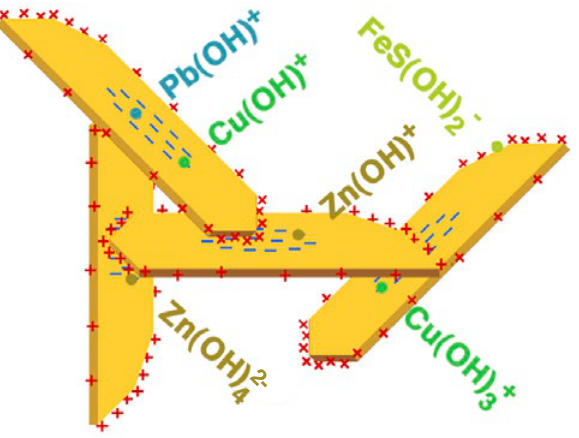
Figure 66. Metal ions hydrolyse or form complexes with water in solution. Charged ions and complexes are removed from solution by adsorption on sediment substrates such as clays, amorphous sili- ca, and organic matter.